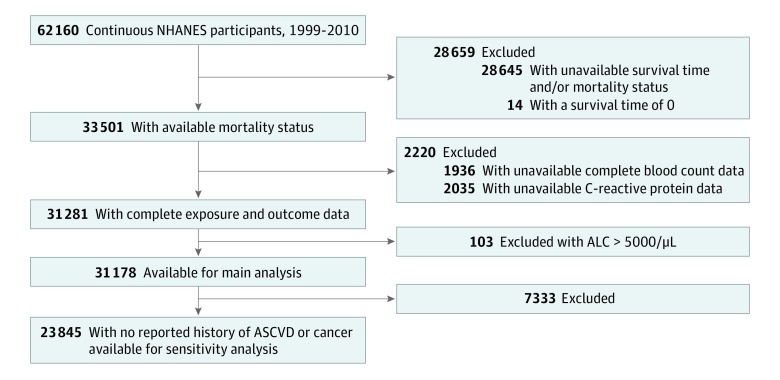
Study Flow DiagramThe study population for the main analysis (n = 31 178) consisted of participants continuously enrolled in the 1999-2010 National Health and Nutrition Examination Survey (NHANES) who had complete blood cell count data, no evidence of chronic lymphocytic leukemia (absolute lymphocyte count [ALC]<5000/μL [to convert to 109 per liter, multiply by 0.001]), C-reactive protein levels measured, and survival data. A sensitivity analysis excluded participants with a history of cardiovascular disease or malignant disease (n = 23 845). ASCVD indicates arteriosclerotic cardiovascular disease.